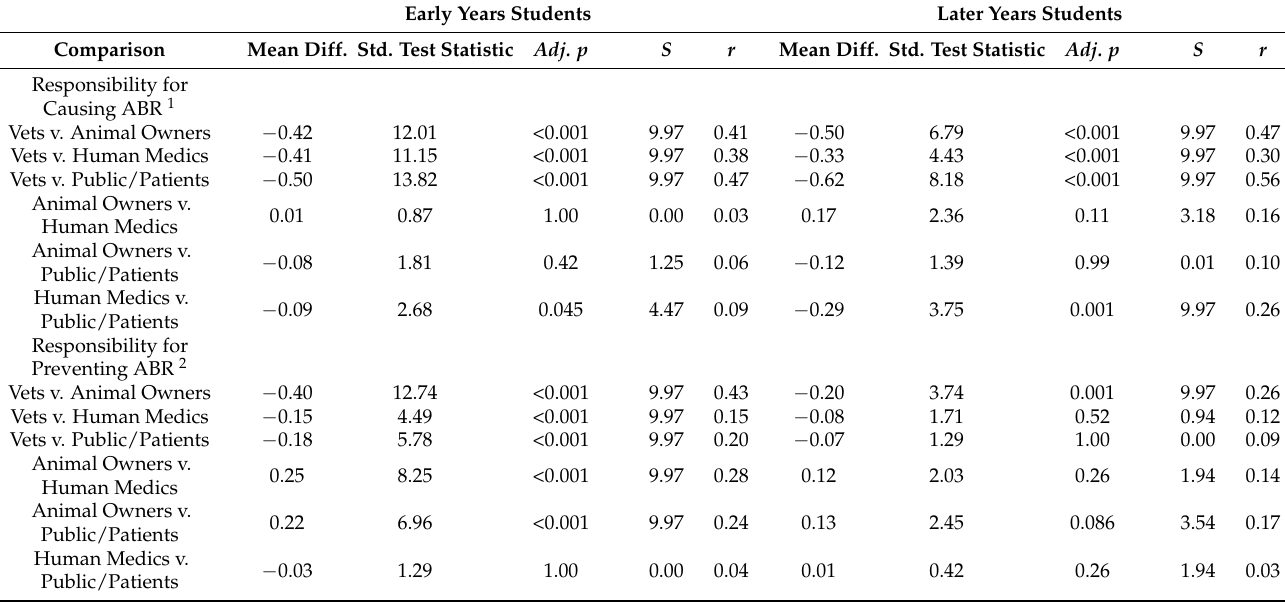
Table 7. Pairwise comparisons for beliefs about groups’ responsibility for causing and preventing